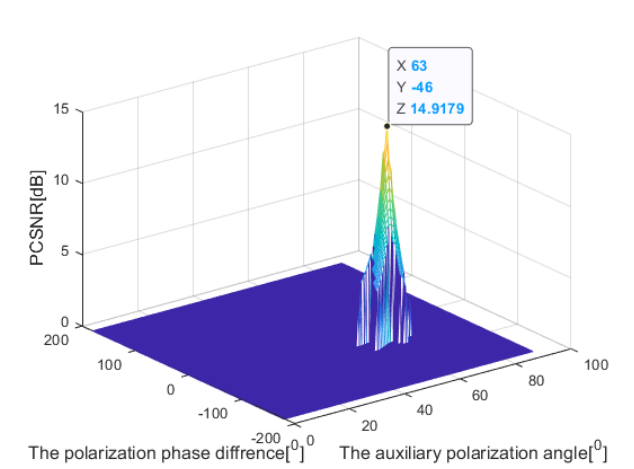
Figure 1. PCSNR of signals under different received